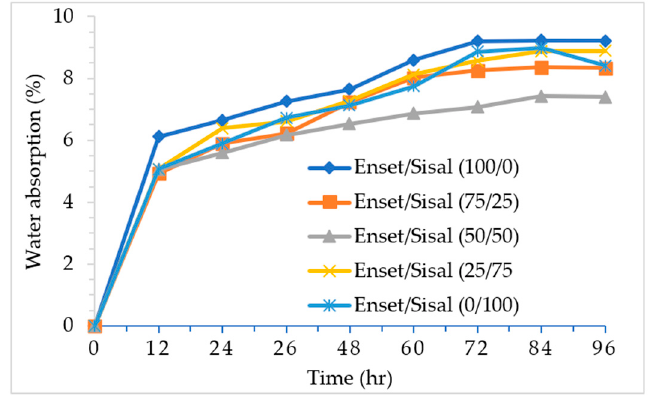
Figure 7. Moisture absorption test result of hybrid enset–sisal hybrid composites.